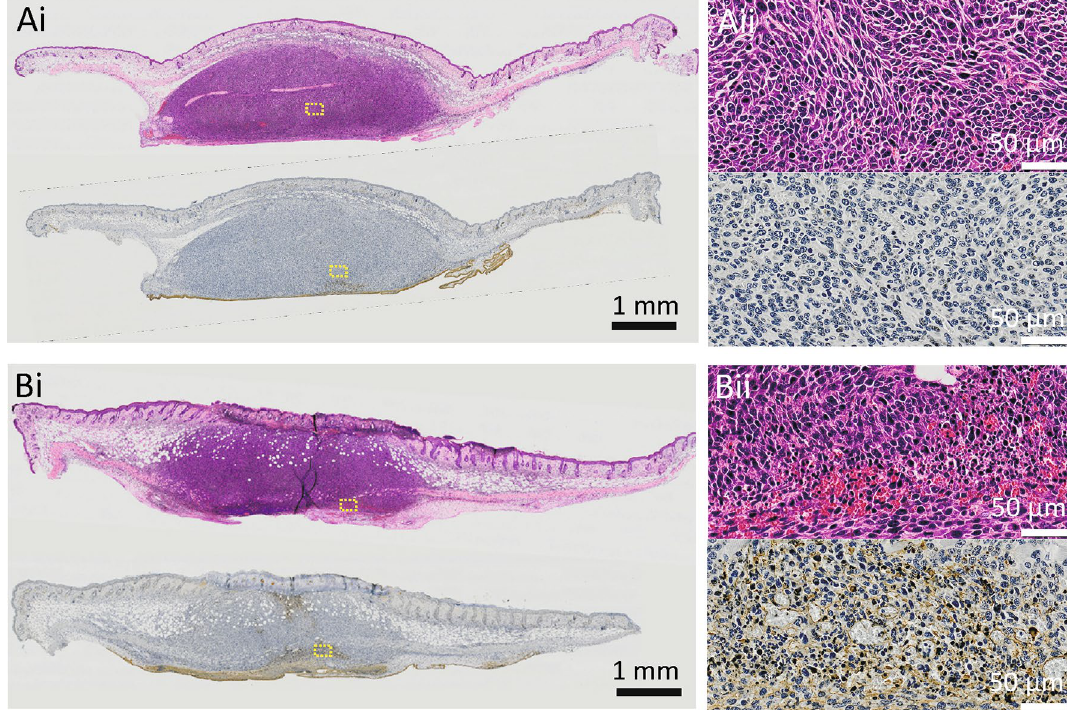
Figure 6. Histopathological photographs (H&E staining (upper) and Tunel staining (lower)). (Ai) Day 3 of an untreated tumor (ALA(−)photo(−)). A non-emitting implantable LED device had been placed at the bottom of the photograph. (Bi) Day 3 of an mPDT-treated tumor (ALA( +)photo( +)). An implantable LED device had been placed at the bottom of the photograph, and LED light had been illuminated approximately in the center of the tumor. Photographs of (Aii,Bii) are enlarged views in areas indicated as yellow-line squares in photographs of (Ai,Bi)